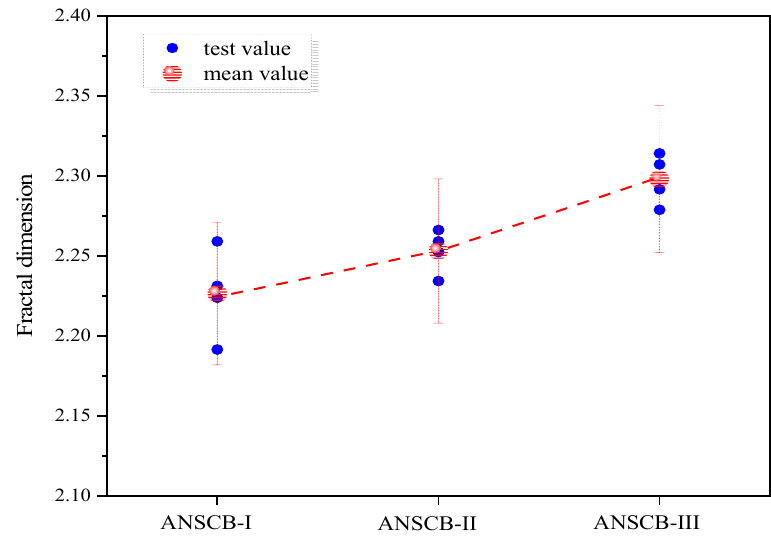
Figure 13. Fractal dimension of the fracture surface.